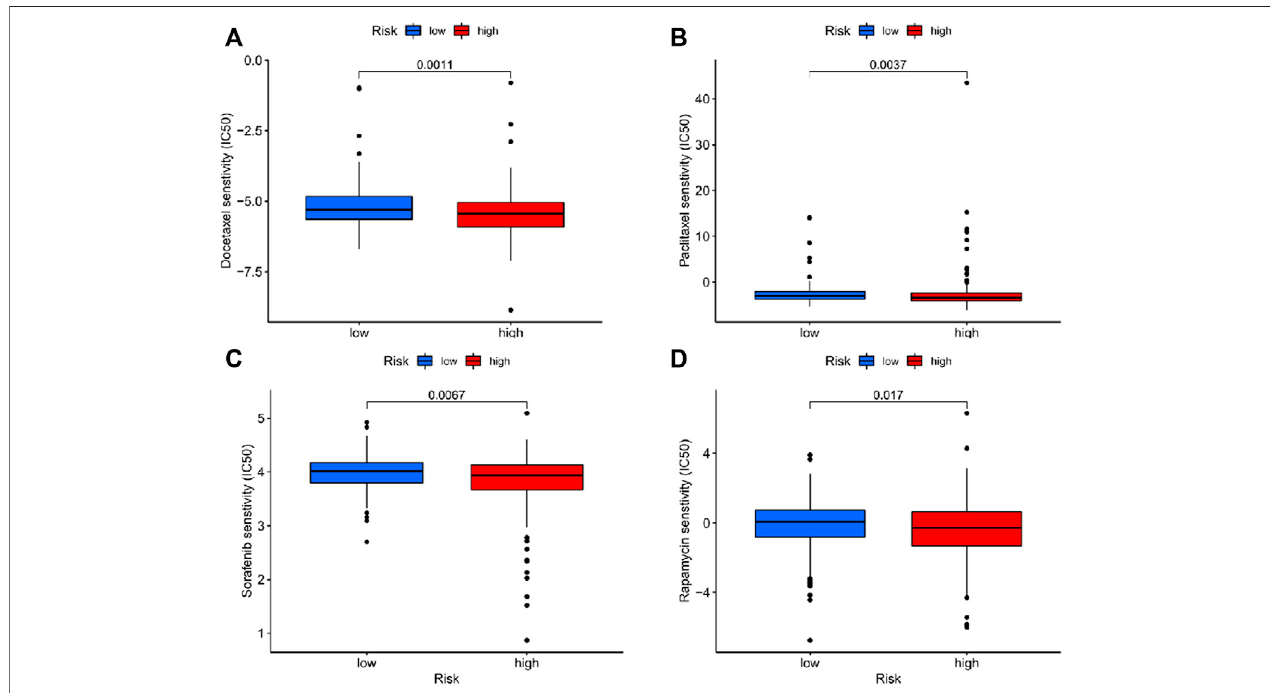
FIGURE 6 | The correlation between different risk groups and drug sensitivity in EC patients. (A) Docetaxel; (B) Paclitaxel; (C) Sorafenib; (D) Rapamycin.